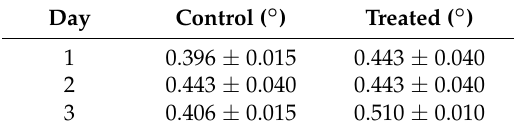
Table 5. Titratable acidity of treated and untreated fermented wash during fermentation.